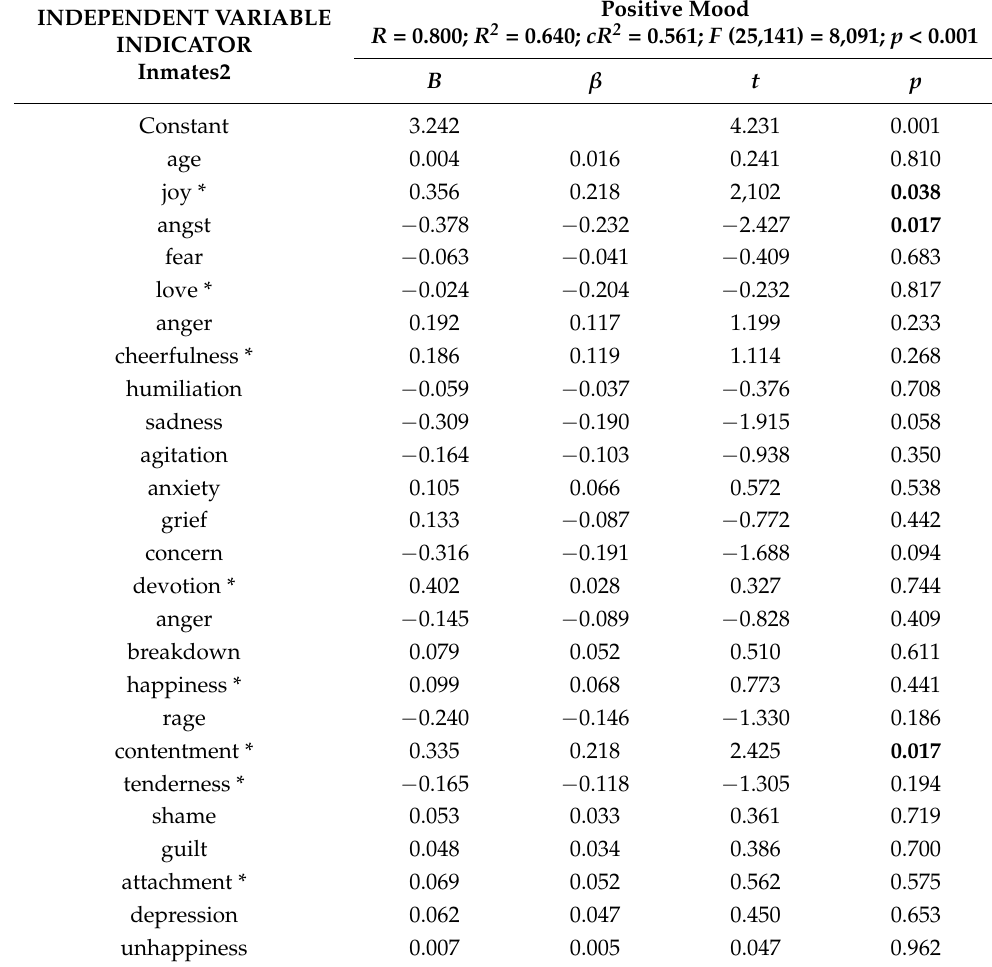
Table 10. Linear regression results, the dependent variable of positive mood in